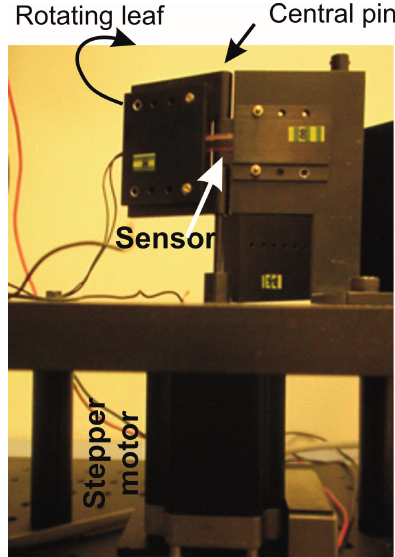
Figure 2. The setup was to measure the electrical behavior of the sensor when flexed to different angles. A stepper motor moves the rotating leaf of a hinge and a multimeter records the resistance value of the sensor. A Labview ® routine controls the overall